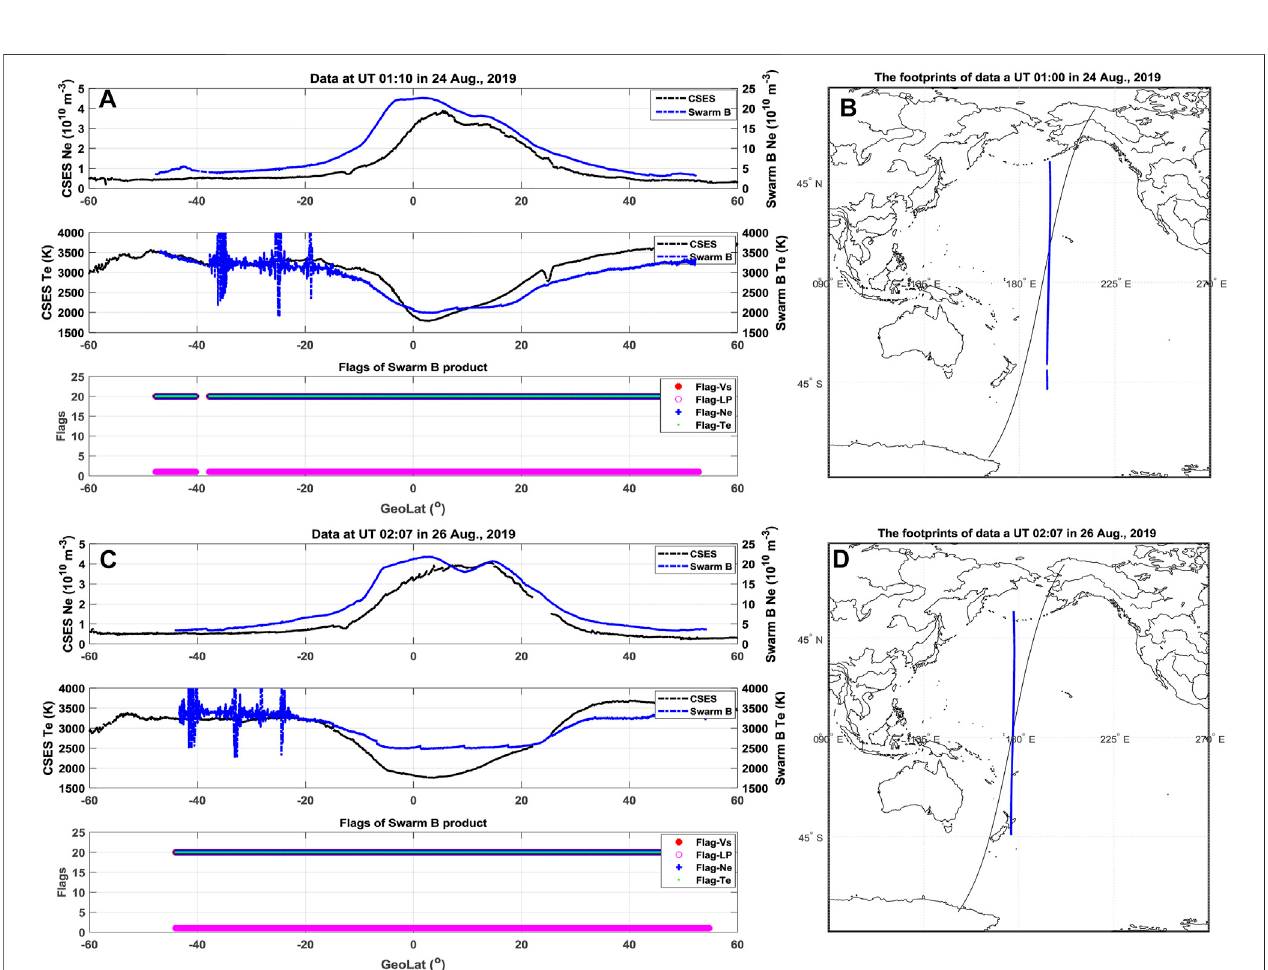
FIGURE 10 | (A,C) are the latitudinal pro fi les of Ne/Te from the CSES (black) and Swarm B (blue) when they are close in time and space. In addition, the fl ags of SwarmLPproductareshowninthebottompanelsof (A,C) .Thetwoexamplesaretakenon24and26August2019,andtheirfootprintsofthetwosatellitesareshownin Figure (B,D)